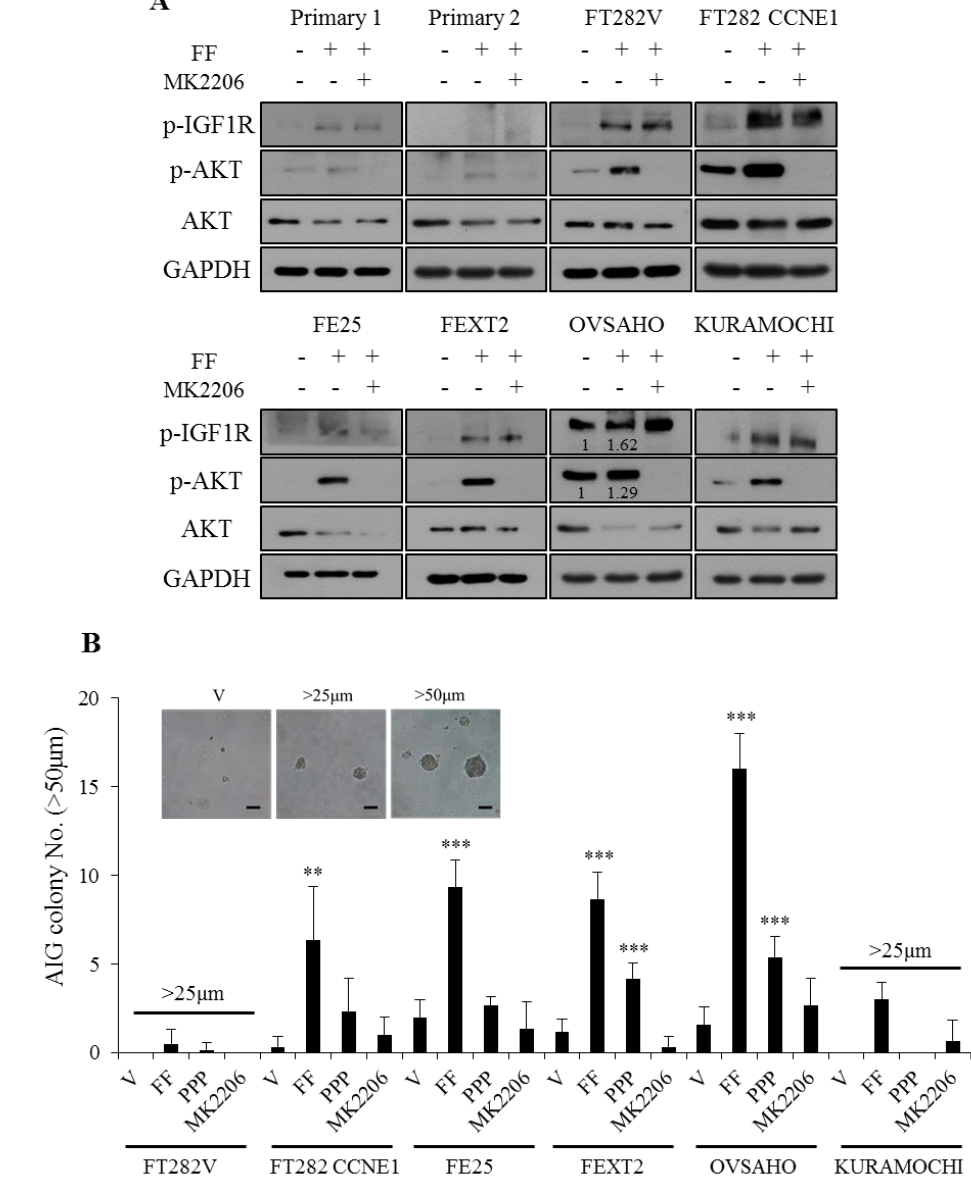
Figure 2. FF promotes anchorage-independent growth of FTE /HGSC cells in correlation with the phosphorylation of IGF-1R /AKT. ( A ) IGF-1R, AKT and their phosphoproteins in primary FTE cells, transforming FTE cells and HGSC cells with or without FF and/or AKT inhibitor (MK2206). Cells were pretreated for 30 min with MK2206 (10 µM) or vehicle before the addition of 10% FF or PBS. Western blot was performed after 30 min. ( B ) AIG of the six cells with the same pretreatments. Colonies over 50 µm (more number of transformed cells) or over 25 µm (less number of transformed cells) were counted after 14 days culture. Scale bar, 50 μm. Results are from three independent experiments, the asterisk represents comparison of vehicle. ** p < 0.01, *** p < 0.001 by two-sided, unpaired Student’s t -test. Full uncropped Western Blot images are available in Figure S2.